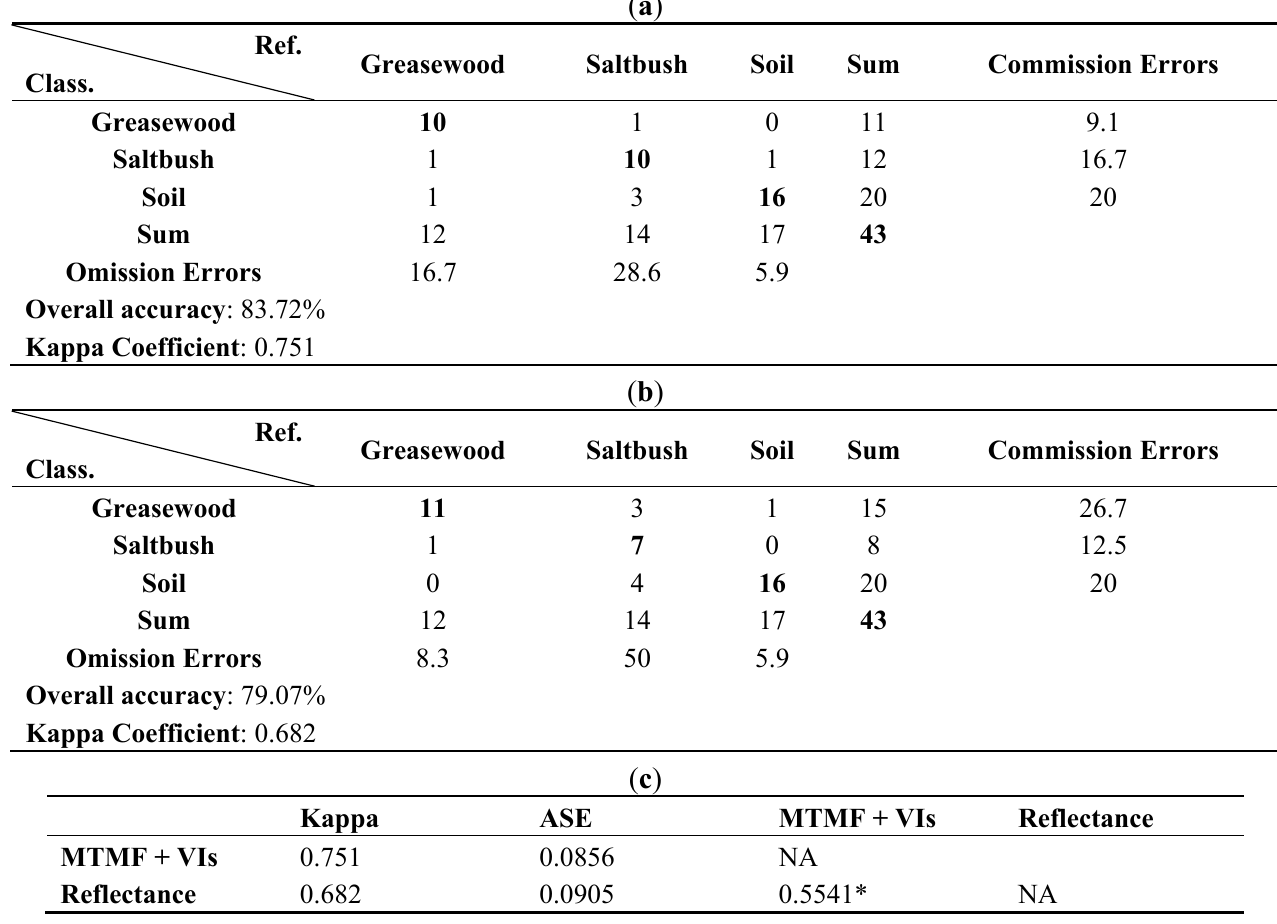
Table 6. Accuracy assessment results of the decision tree classifications for the Monument Valley site: ( a ) using the MTMF variables and vegetation indices, ( b ) using the scaled reflectance data, and ( c ) Kappa Z-test between the two